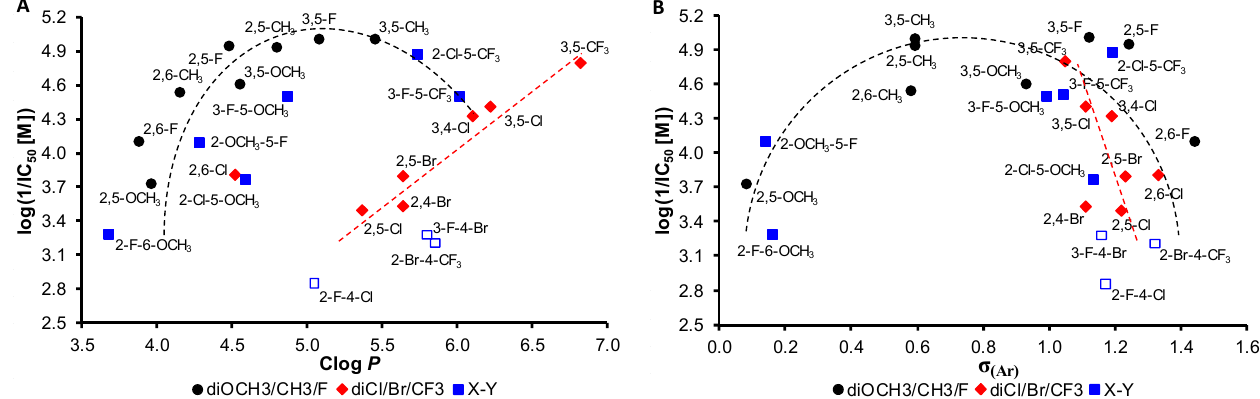
Figure 2. Dependence of PET-inhibiting activity log(1/IC 50 [M]) of all discussed compounds 1 – 24 in spinach chloroplasts on lipophilicity expressed as Clog P ( A ) and electronic σ parameters of whole N -aryl part of individual anilides ( B ). Empty squares are not involved in SAR discussion due to their inactivity.